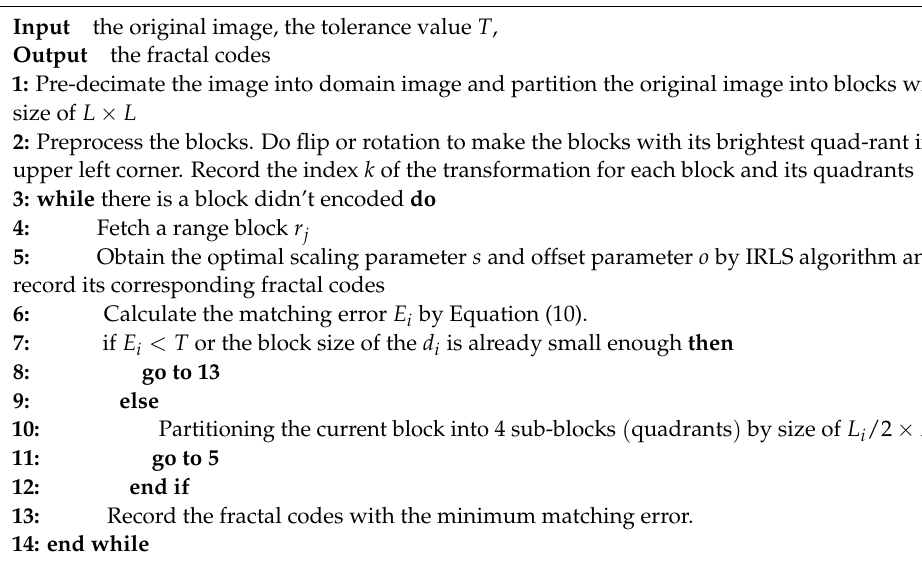
Algorithm 3 The Robust M-estimator for FIC algorithm